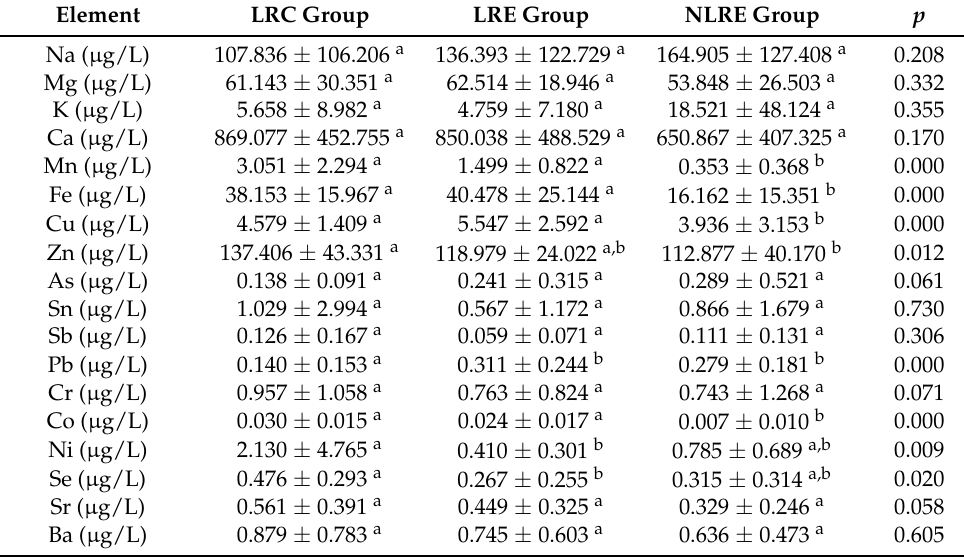
Table 5. Element concentrations in fingernails in the LRC group, LRE group and NLRE group 1